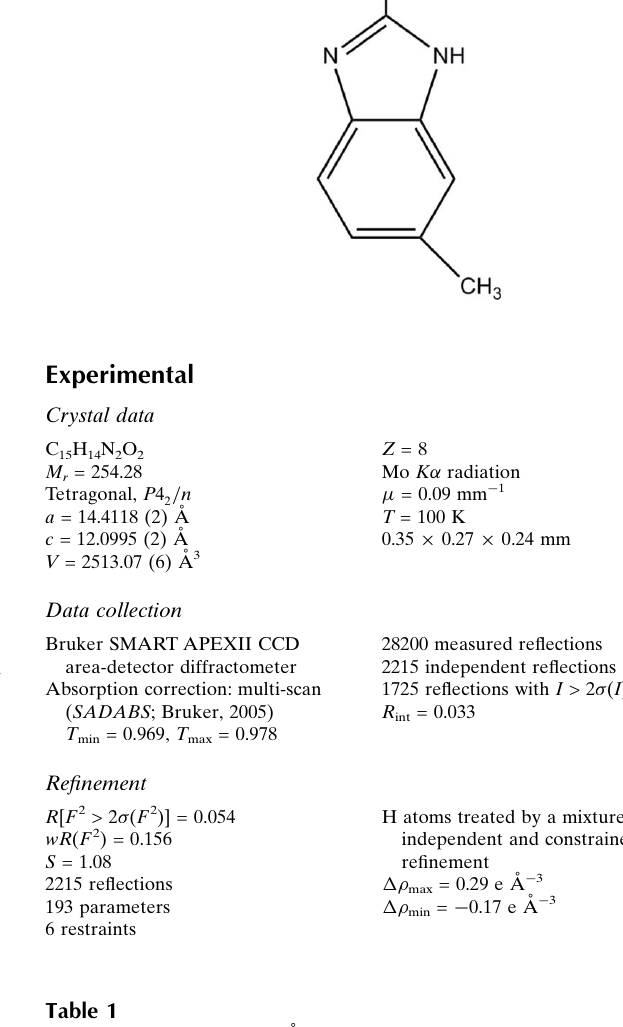
Hydrogen-bond geometry (A˚ , (cid:2)